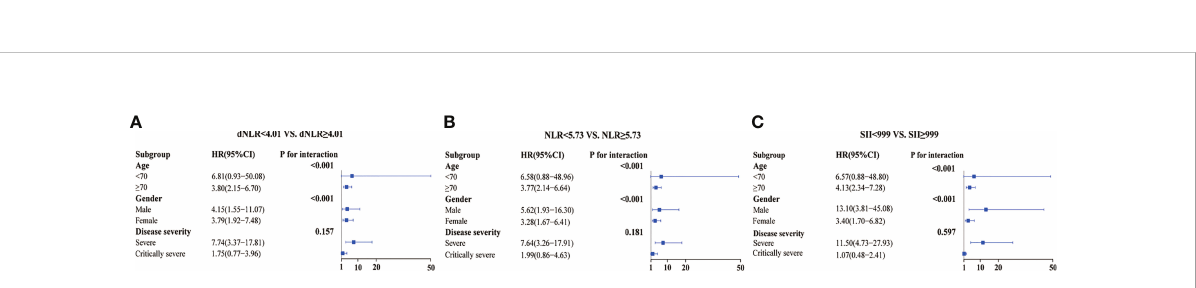
FIGURE 4 Sub-group analysis of three in fl ammation indicators in COVID-19 Omicron BA.2 infected patients. (A – C) Sub-group analysis of dNLR, NLR, and SII in patients. (A) Derived neutrophil to lymphocyte ratio (dNLR), (B) neutrophil to lymphocyte ratio (NLR), (C) systemic immune-in fl ammation index